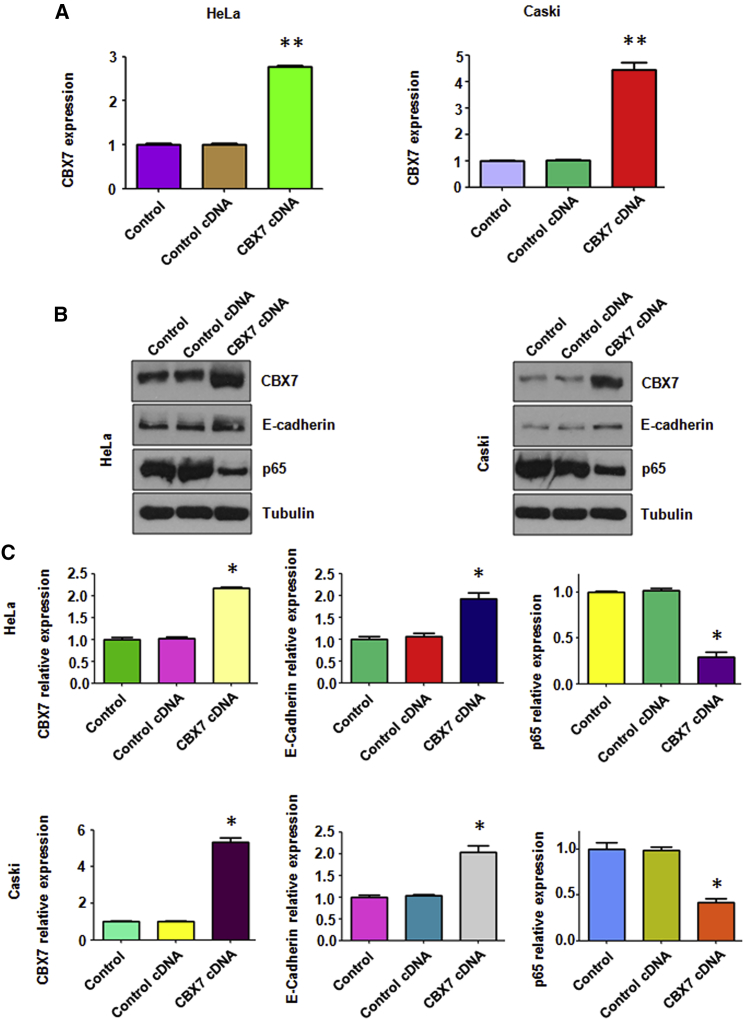
Overexpression of CBX7 Increases E-cadherin and Decreases the NF-κB Level(A) The CBX7 mRNA level was detected by real-time PCR in both HeLa and Caski cells with CBX7 construct transfection. **p < 0.01 versus control group. (B) Western blot was performed to analyze the protein level of CBX7, E-cadherin, and NF-κB in cervical cancer cells with CBX7 construct transfection. (C) Quantification of the expression of CBX7, E-cadherin, and NF-κB was performed. *p < 0.05 versus control group.